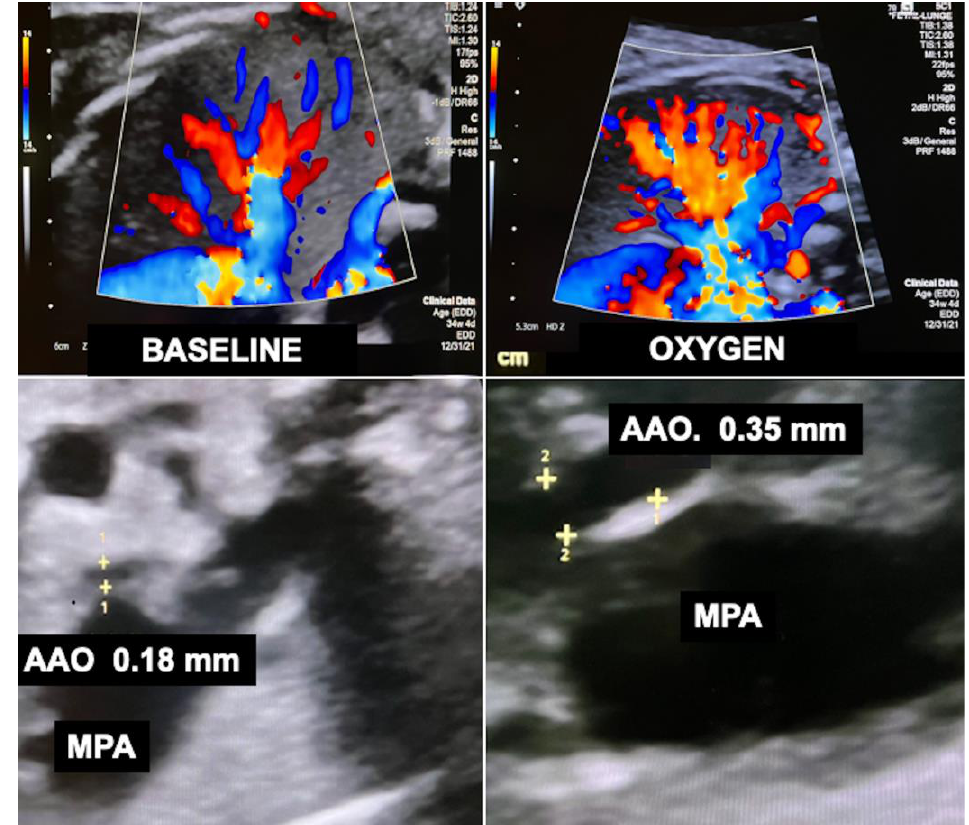
Figure 12. Effect of chronic intermittent materno – fetal hyperoxygenation (Kohl Procedure) on the development of a severely hypoplastic ascending aorta which serves in essence as “the common coronary artery” in a fetus with hypoplastic left heart syndrome. Top — color Doppler interrogation of the fetal lung before ( left ) and during ( right ) materno – fetal hyperoxygenation demonstrates a marked increase in flow signals. Bottom left — at the beginning of therapy at 34 + 4 weeks of gestation, adjacent to the much larger main pulmonary artery (MPA), the ascending aorta (AAO) is difficult to find as it measures only 1.8 mm (z-score − 9.1 after Krishnan et al. 2016 [114]). Its small size constitutes a risk factor for the postnatal occurrence of cardiac ischemic events. During materno – fetal hyperoxygenation, the retrograde flow across the aortic arch and into the ascending aorta increases. Bottom right — after 30 days of daily therapy, the diameter of the ascending aorta has increased to 3.5 – 4 mm (z- score ≥ − 6.2), reducing the risk of cardia ischemia and facilitating the performance of postnatal interventions.